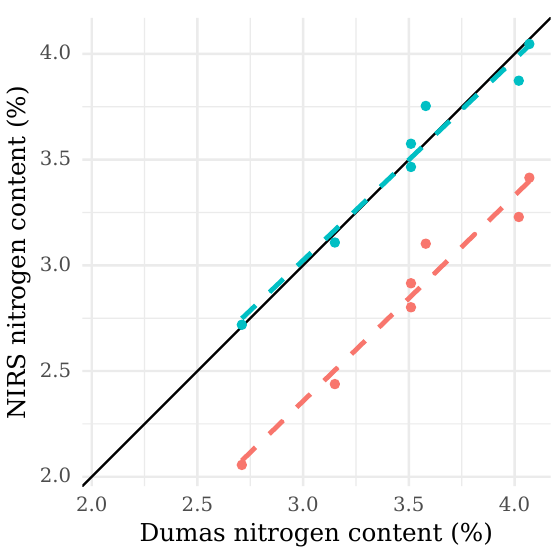
Figure 3. Accuracy validation of nitrogen content ground truth estimates obtained using laboratory near-infrared spectroscopy. The estimated values (the ordinate axis) are compared with Dumas nitrogen content values (the abscissa). The negative bias of approximately 0.75pp relative to the 1:1 line, marked in black, is discernible. Ground truth with the bias removed, which is used in subsequent modeling, is also depicted. The dashed lines correspond to linear regression fits before and after the